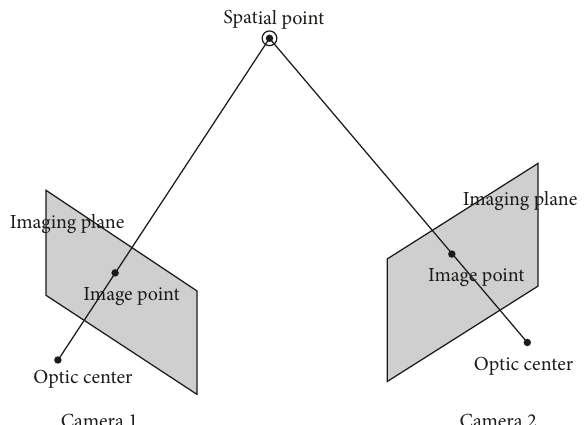
Figure 1: The triangulation